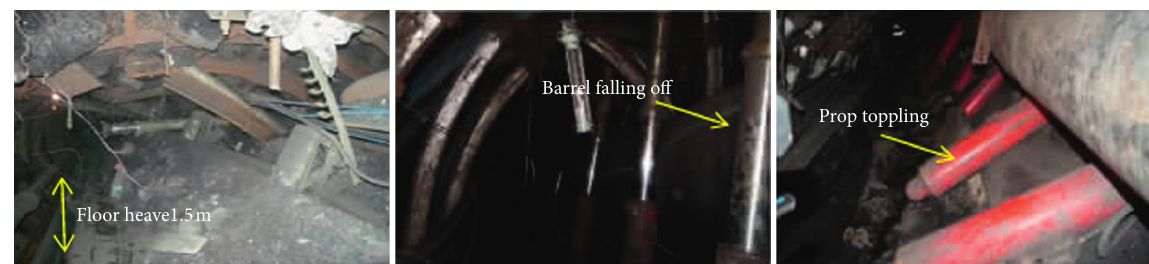
Figure 7: Scene photos of roadway rock burst accident in Qianqiu mine.